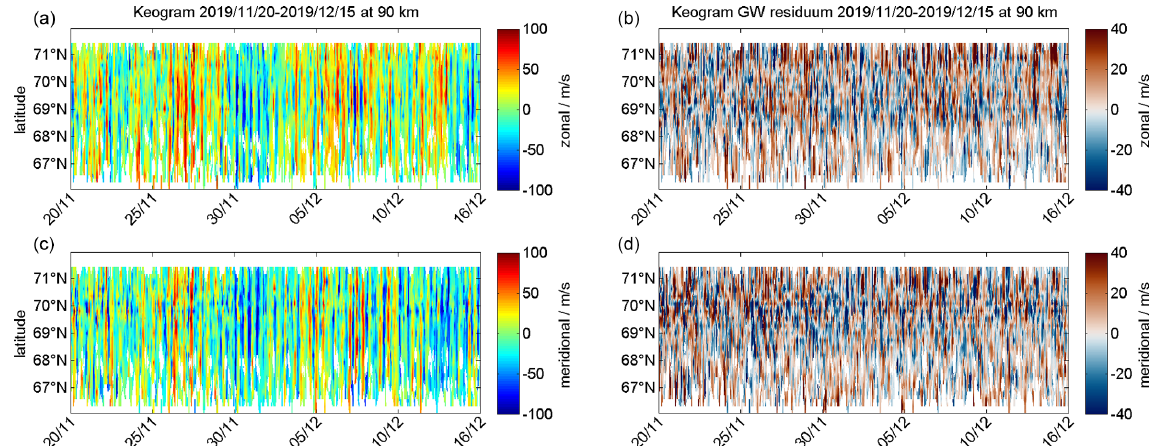
Figure 12. The four panels show color-coded latitudinal keograms of zonal and meridional winds for 22 ◦ longitude and 90km altitude from 20 November to 15 December 2019.